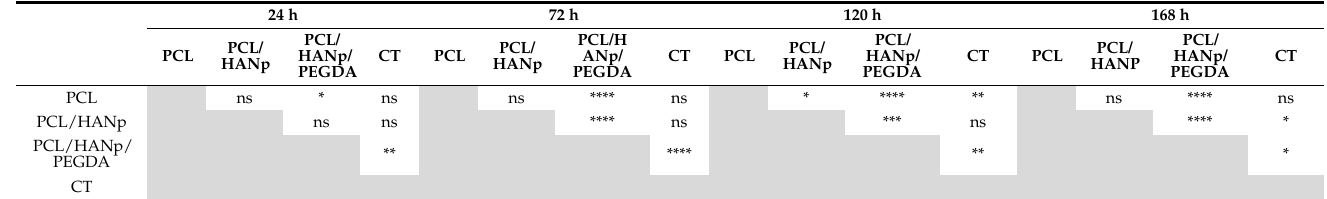
Table 4. Corrected absorbance evaluated by PrestoBlue ® viability assay for hDPSCs after 24, 72, 120 Table 5. Statistical significance of viability assay for hDPSCs after 24, 72, 120 and 168 h (CT—control; and 168 h. Results presented in mean ± SE. ns—not significant). Results significances are presented through the symbol (*), according to the p value, with one, two, three or four symbols corresponding to 0.01 < p ≤ 0.05; 0.001 < p 0.01; 0.0001 < p ≤ 0.001 and p ≤ 0.0001, respectively.